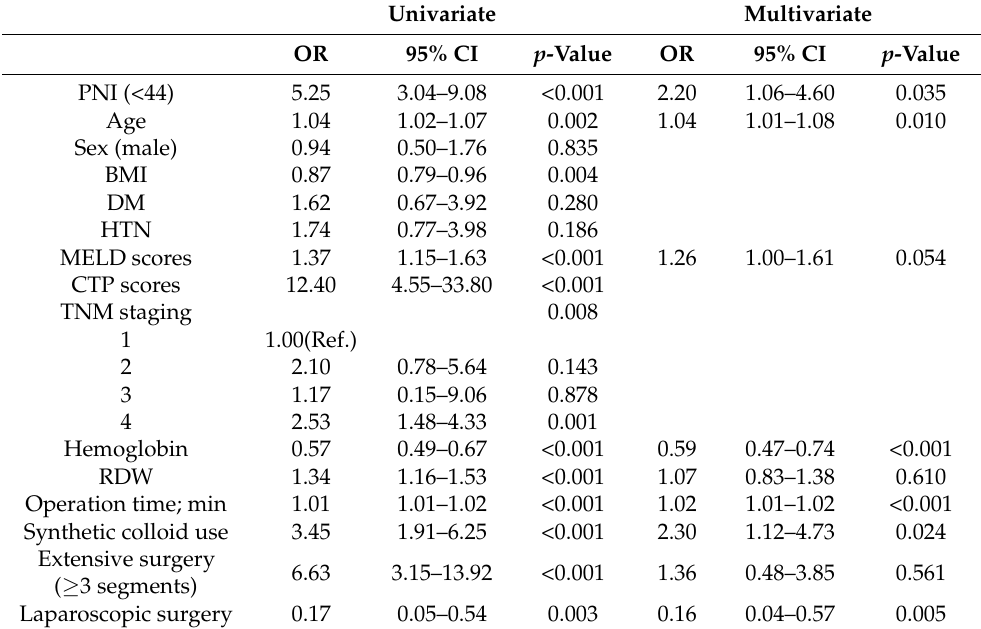
Table 2. Univariate and multivariable analysis of the risk factors of intraoperative